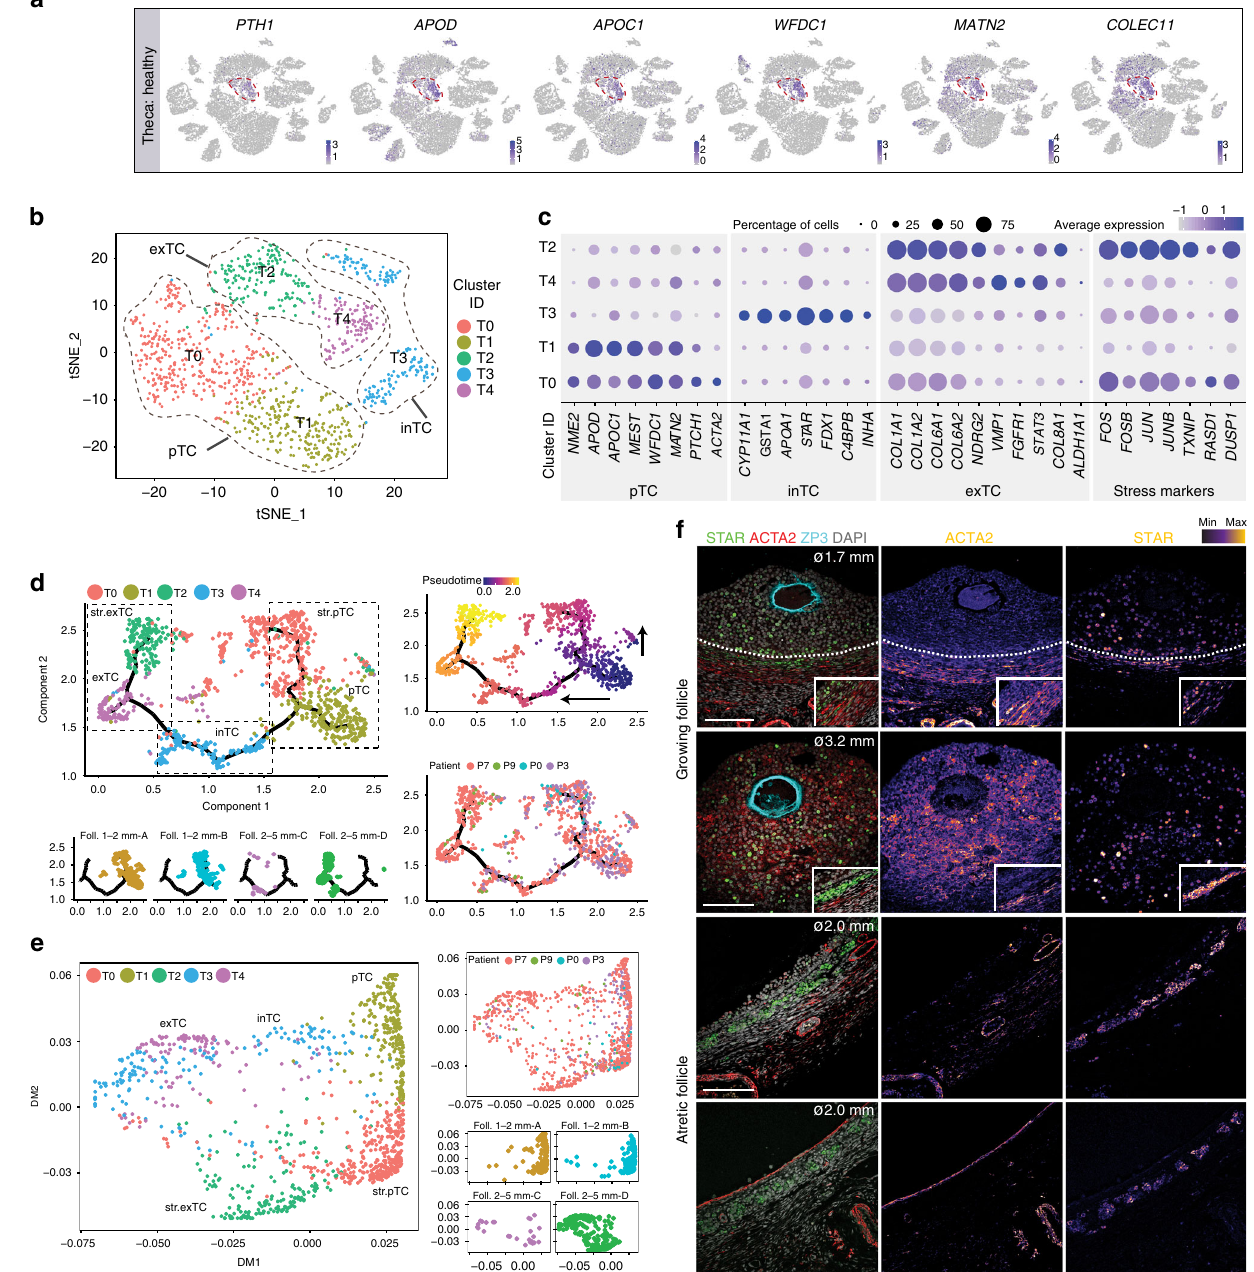
Fig. 7 Divergent populations of theca cells in different follicles. a tSNE cluster map showing expression of selected theca cells (TC) genes. Red dashed lines give the boundaries of the expression. b tSNE cluster map revealing sub-clusters of CL5 representing ovarian TC types. Black dashed lines give the boundaries of several sub-clusters of TC: common progenitor TC (pTC), externa TC (exTC), and interna TC (inTC). c Expression of marker genes in sub- clusters of CL5. d , e Analysis of cell trajectories of TC (CL5) by Monocle a and Diffusion maps b . Individual cells (dots) are colored by cluster, follicle, patient, and pseudotime (Monocle). f Immunostaining of follicles (ø, diameter) growing (top two rows) and atretic (bottom two rows) for STAR, ACTA2, and ZP3. Inset shows mural GC of the same follicle with same magni fi cation. Single channel images were converted to an intensity map. White dotted line marks the basement membrane. Scale bars are 100 μ